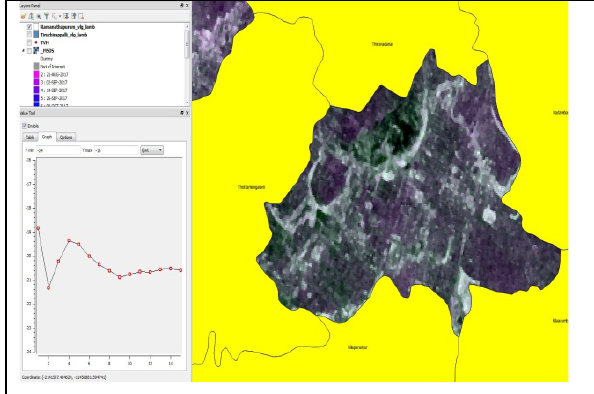
Fig. 4a. Temporal signature for Failed sowing